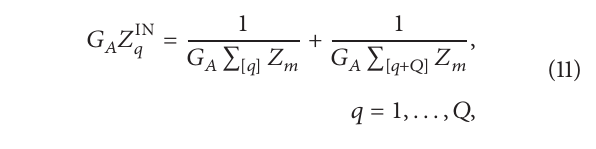
Figure 3: (a) An example of subarrays structure; (b) feeding waveguides and input ports; (c) complete array.